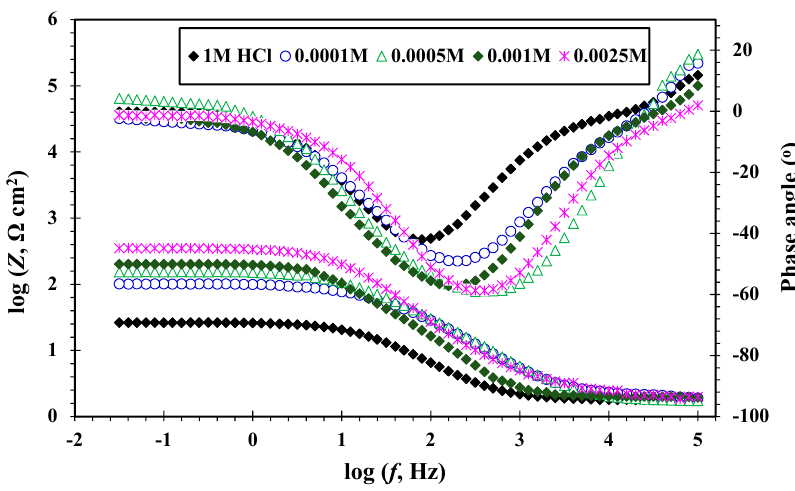
Figure 10. Bode plots for MS in 1 M HCl in the absence and presence of different concentrations of CGSES12 at 20.